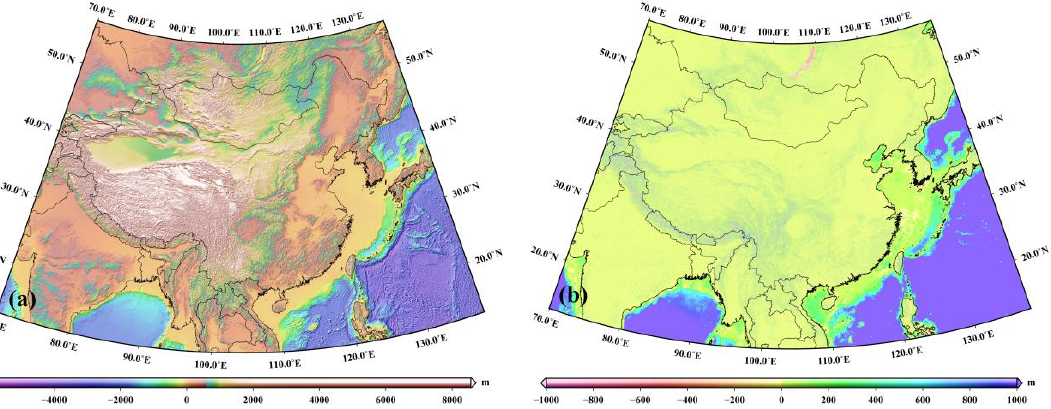
Figure 2. ( a ) Topography based on merged SRTM and ( b ) residual terrain model (RTM) elevations with RET2012 terrain as the reference surface.